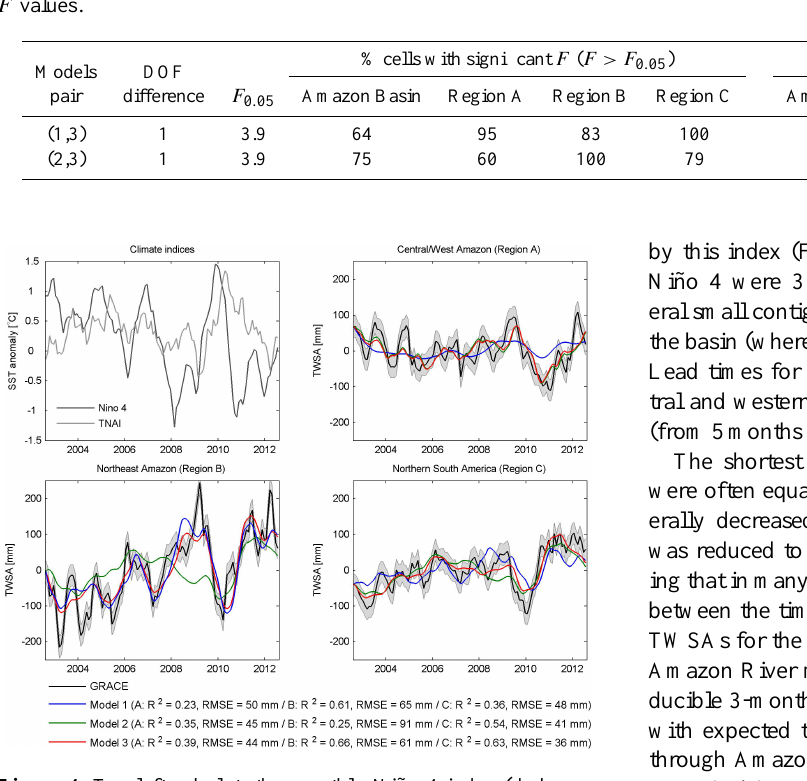
Figure 4. Top left subplot: the monthly Niño 4 index (dark gray line) and the Tropical North Atlantic Index (light gray line), af- ter subtracting their respective mean over the GRACE period. Top right and bottom subplots: GRACE-observed (black line) with mean monthly error (gray shaded area) and model-predicted TWSAs for each of the three regions delineated in Fig. 1a, for the three mod- els described in Table 1. Regional averages of model performances (Table 2) are also provided for each model. The prescribed mini- mum lead time between the climate indices and TWSAs was equal to